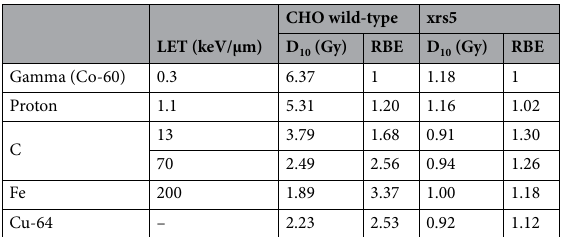
Table 1. Values of D 10 and RBE of various types of radiations 10 . LETs of gamma rays from Co-60, protons, C and Fe ions are also